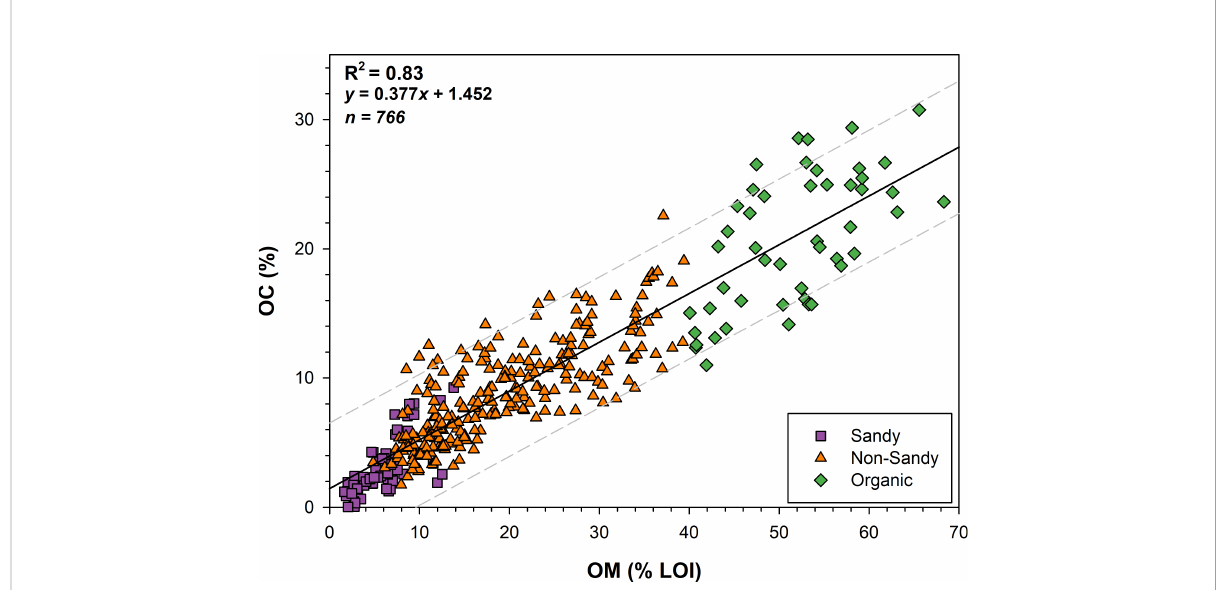
FIGURE 4 Correlation between the quantity of OM measured by loss on ignition (LOI) and OC content derived from elemental analysis for 766 saltmarsh soil samples of differing texture (sandy, non-sandy and organic) from across Great Britain (p < 0.001; R 2 = 0.83). Grey dotted lines represent the 95 th percentile prediction